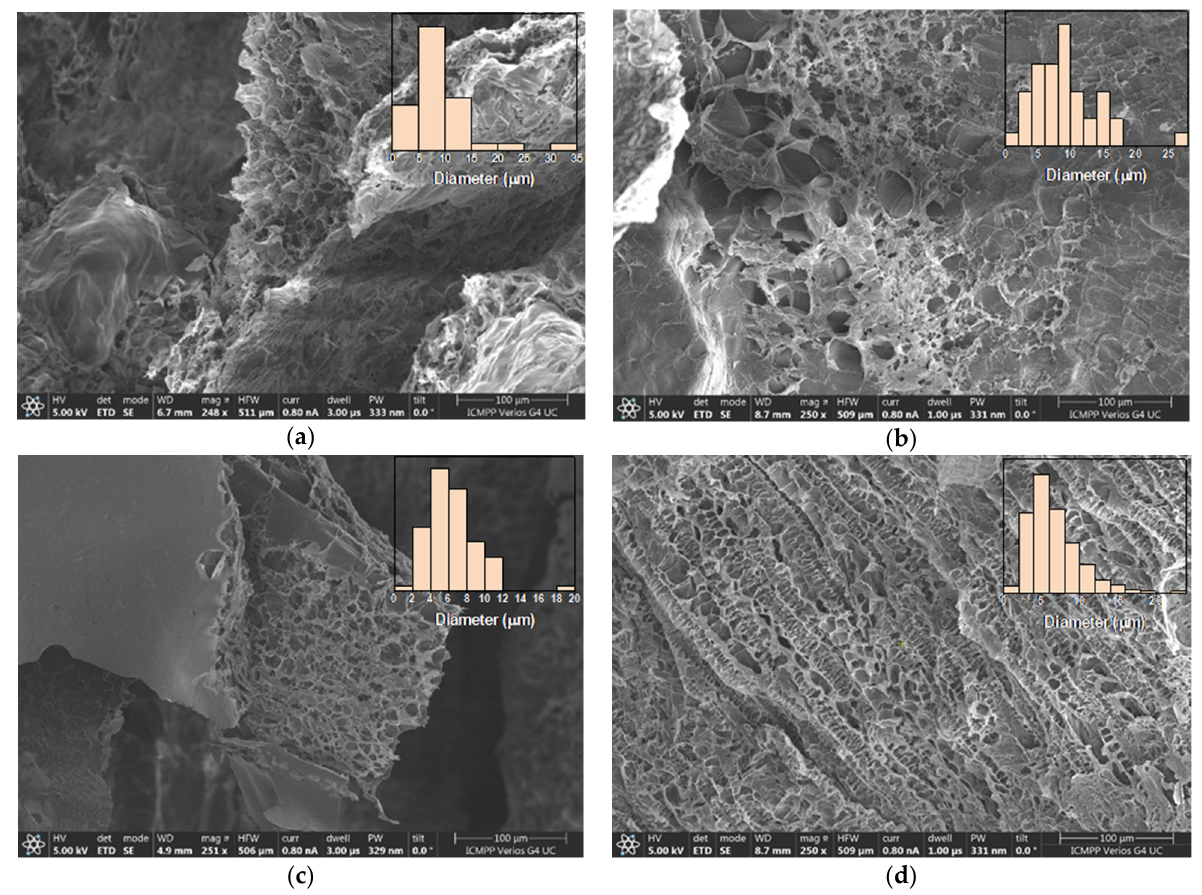
Figure 5. Representative SEM images of the xerogels: a) 2X, b) 4X, c) 6X, d) CX. In the inset, the histograms of pores’ dimensions are given.